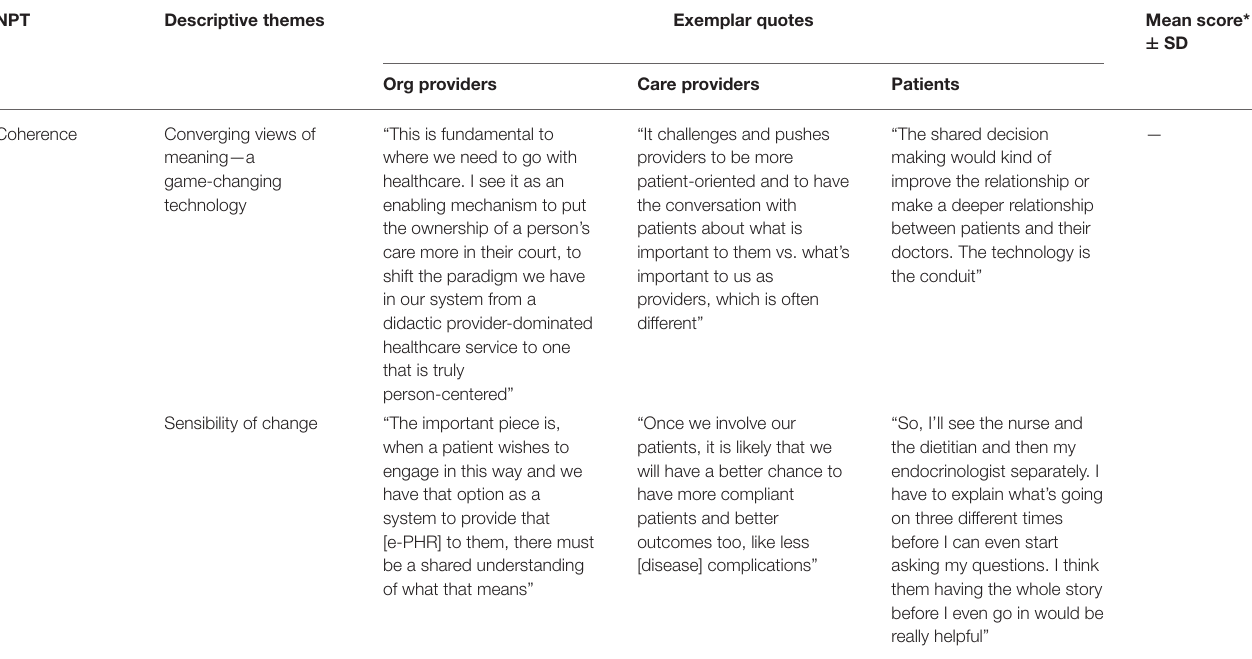
TABLE 4 | Combined qualitative and quantitative results for coherence by study